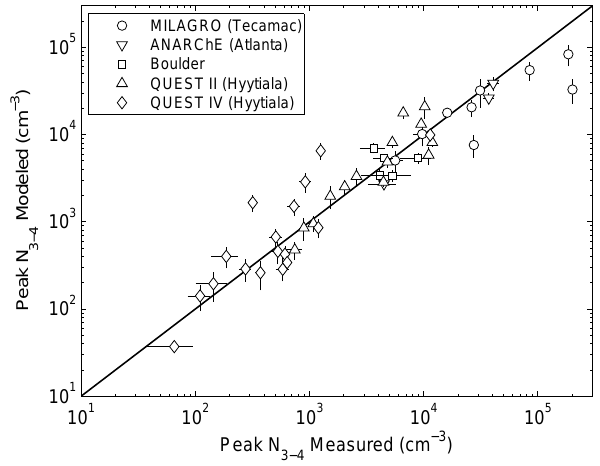
Fig. 1. Comparison of measured and modeled peak ultrafine particle number concentrations ( N 3 − 4 ) for forty-eight new particle forma- tion events measured during the field campaigns (location) listed in the figure legend; results from EUCAARI are not included. The solid diagonal line represents perfect agreement between model re- sults and measurements. Vertical and horizontal bars represent mea- sured ranges associated with the maximum sulfuric acid concentra- tion and uncertainties associated with the measured particle counts,